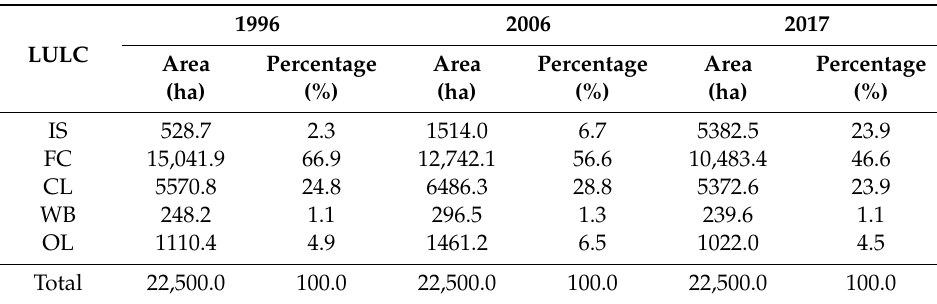
Table 5. LULC areas with